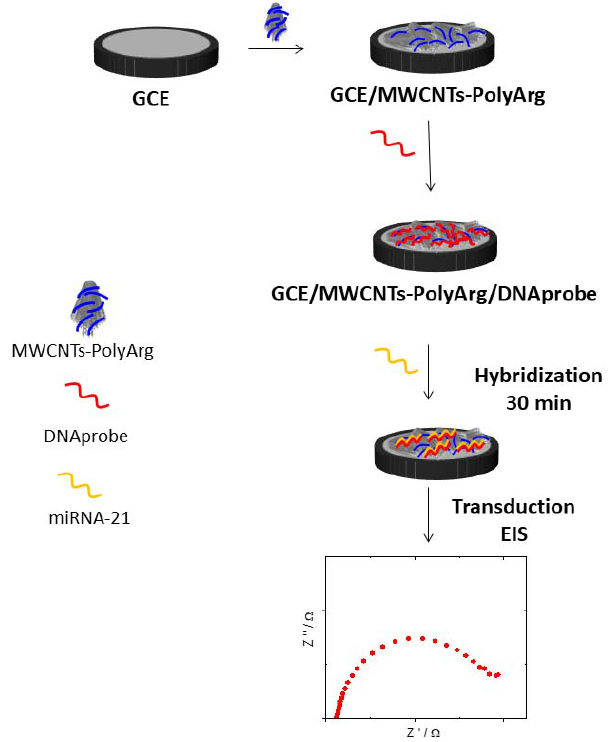
Figure 2. Schematic representation of the genosensor